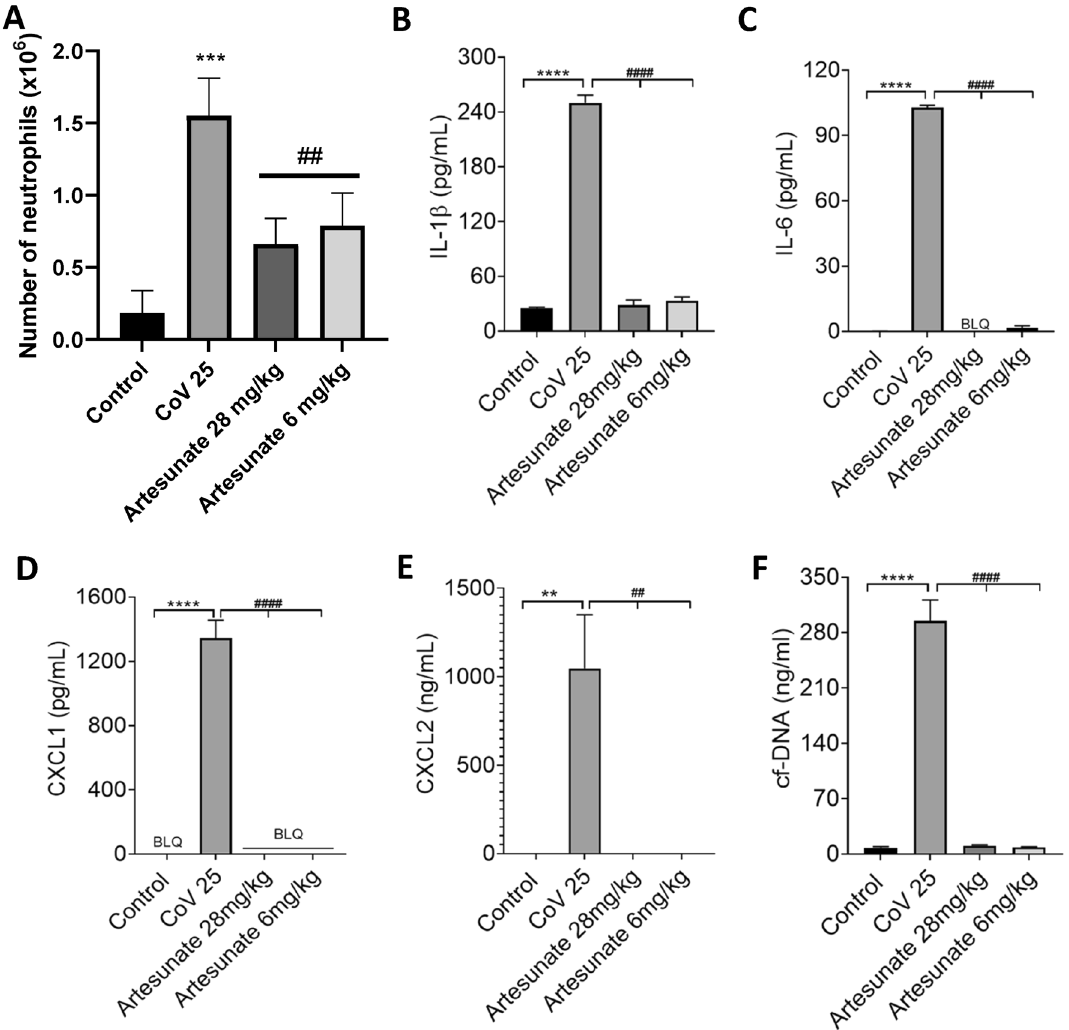
Figure 5. Artesunate suppresses neutrophil invasion, release of cytokines and release of NETs in response to infusion of SARS-CoV-2 spike protein into lung. Number of neutrophils (A), levels of cytokines (B- E) and NETs (F) recovered from broncho-alveolar lavage fluid (BALF), 24 h after infusion of CoV (SARS-CoV-2 spike protein, 25 μg each lung). CoV causes an influx of neutrophils that is suppressed by artesunate, delivered s.c. 30 min before and then at 90 and 210, 330, 450, 570, 690, 810, 1200 and 1320 min after injection of LPS. Each bar shows mean ± SEM from n = 3 mice. BLQ, below limit of quantitation. Statistical analysis: ** p < 0.01, *** p < 0.001, **** p < 0.0001 compared to control; ## p < 0.01, #### p < 0.0001 compared to CoV. (One-way ANOVA and Bonferroni post-hoc